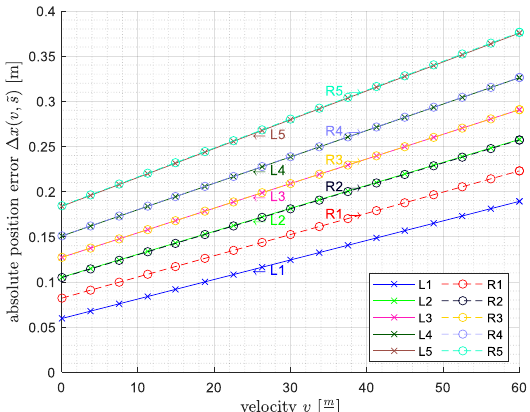
Figure 6. Absolute spatial error of the ground-truth per sensor as a function of velocity. The acceleration signals were combined into one data matrix: A 36,000 × 5 sors L1–L5 and A 36,000 × 5